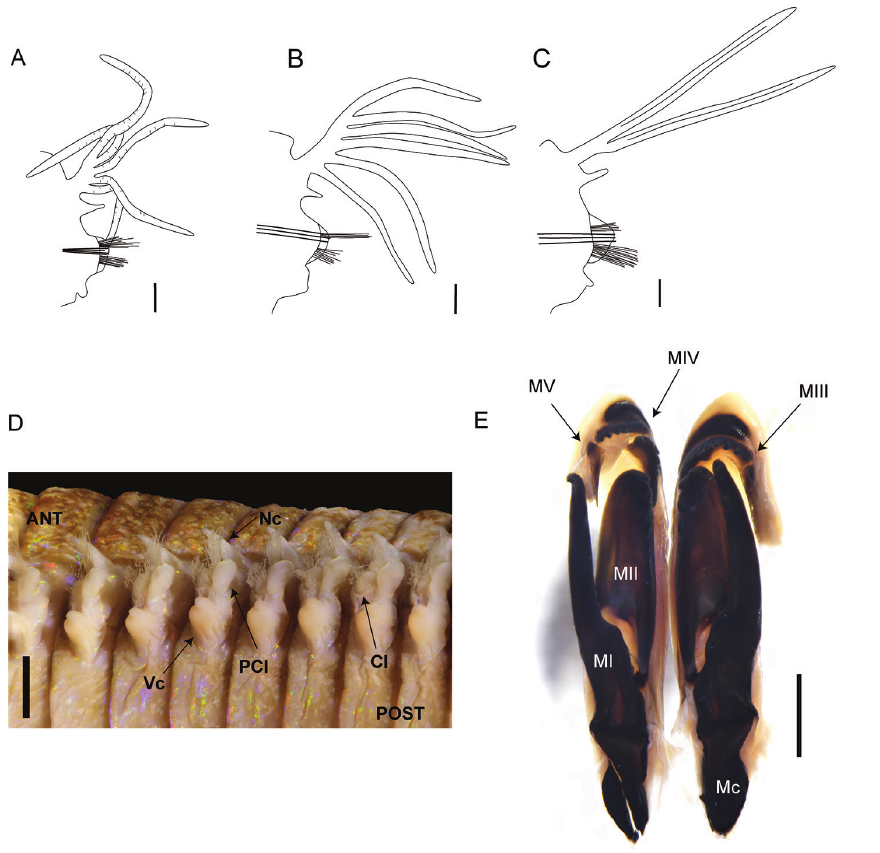
Figure 3. Marphysa victori sp. n.: A Parapodia from anterior chaetiger (chaetiger 57, paratype MNHN- Arc4) B Parapodia from mid-body (chaetiger 127, paratype MNHN-IA-TYPE 1803) C Parapodia from posterior chaetiger (chaetiger 352, paratype MNHN-IA-TYPE 1803) D Anterior parapodia (from chaeti- ger 8 to 15), lateral view E Maxillae dorsal view (paratype MNHN-IA-TYPE 1809). ANT: anterior part; Cl, Chaetal lobe; Mc, maxillary carriers; MI to MV, maxillae I to V; Nc, notopodial cirri; PCl, postchaetal lobe; POST, posterior part; Vc, ventral cirri. Scale bars: 0.5 mm ( A, B, C ), 1 mm ( D, E ). absent. Pectinate chaetae present from chaetiger 2. Up to 34 pectinate chaetae within a parapodia restricted to supra-acicular fascicle of chaetae. Pectinate chaetae of four types. In anterior parapodia, isodont, symmetrical pectinate chaetae (n<10) with 12–16